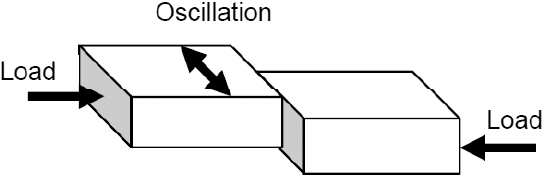
Fig. 1. Schematic of linear friction welding.